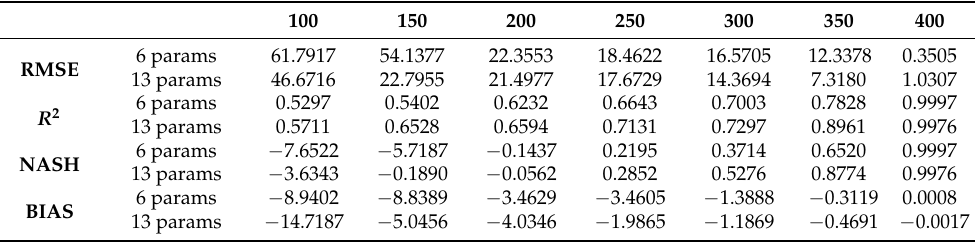
Figure 6. Results for the four statistical indices including RMSE (upper left), R 2 (upper right), NASH (lower left), and BIAS (lower right) for the maximum displacement estimation using 13-floor building. Table 5. Statistical results for different parameters and various sampling sizes based on the 13-floor building.